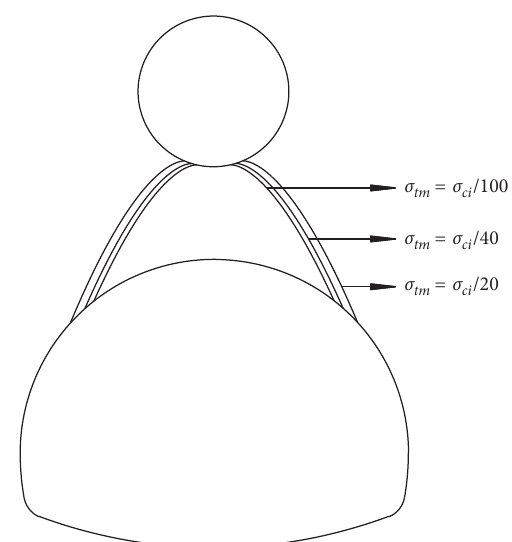
Figure 7: The shape and range of the collapse surface for different values of σ